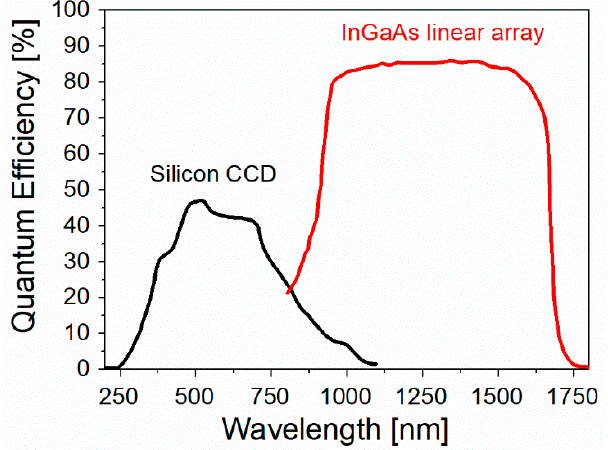
Figure 20. Typical quantum efficiency of a silicon (black line) and of an Indium gallium arsenide (InGaAs, red line) detector: The first corresponds to a Symphony II front illuminated charged coupled device (CCD) and the second one to a Symphony II 1700 InGaAs linear array. Data adapted with permission from Horiba Scientific (https://www.horiba.com).